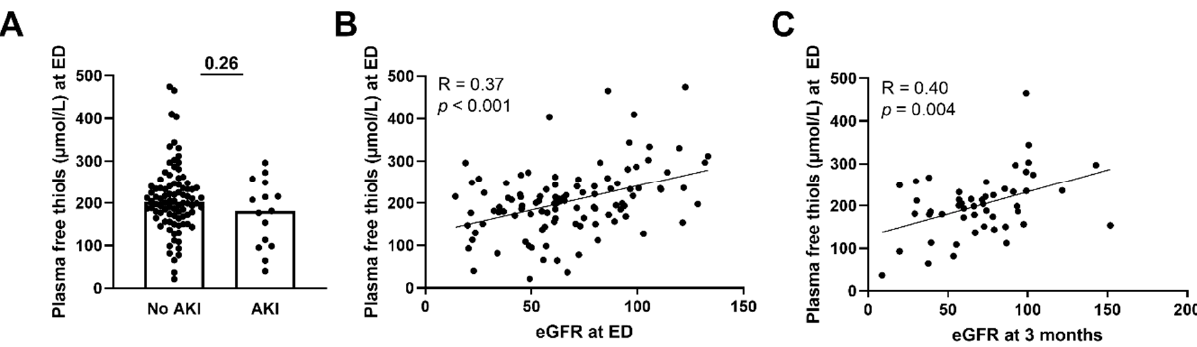
Figure 4. Correlation of plasma free thiols with kidney function. ( A ) Plasma free thiol levels at the ED in patients with and without AKI. ( B ) Correlation of plasma free thiols and eGFR at the ED. ( C ) Correlation of plasma free thiols and eGFR at three months. Statistical analysis in panel A was performed using a Mann–Whitney U test. Bars represent the median; dots represent individual levels.